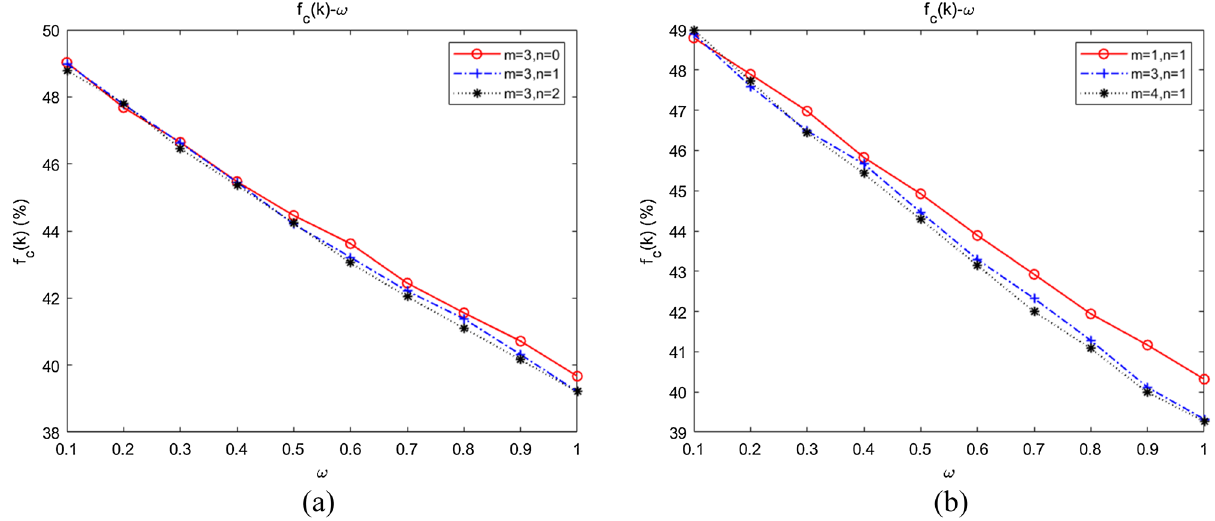
Figure 10. Dependence of the emergence of collaboration on the relative degrees of m and n . ( a ) The influence of fixed n , m on collaboration; ( b ) the influence of fixed m , n on